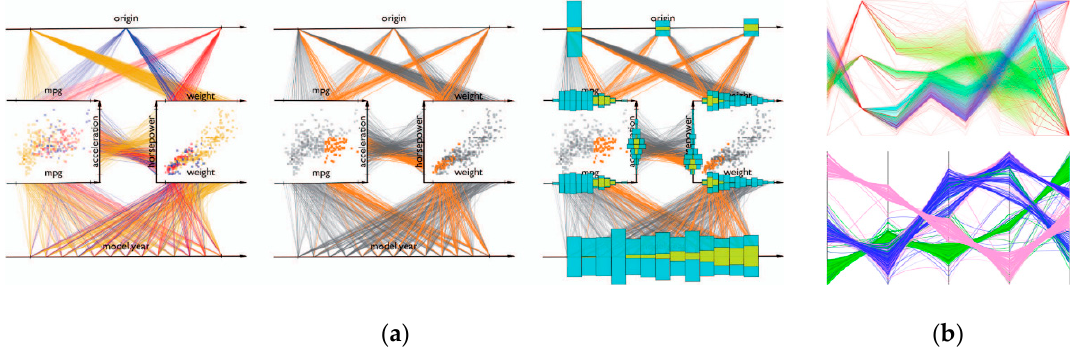
Figure 36. ( a ) FLINAPIots visualization integrating scatter plots and histograms [93]; and ( b ) aggregation for parallel coordinates [94,95].